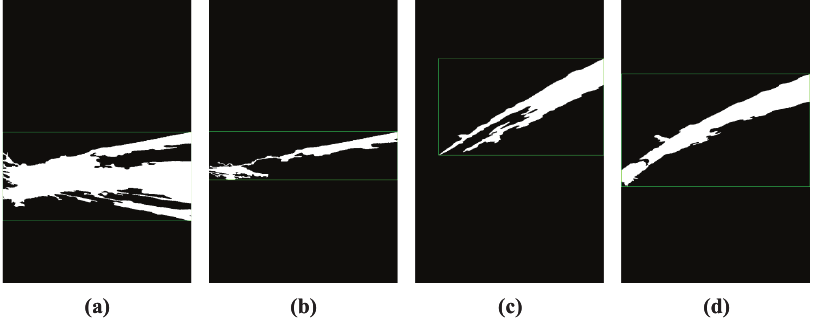
Figure 2. Different jet trajectory segmentation results. ( a ) wrongly trajectory result 1; ( b ) wrongly trajectory result 2; ( c ) wrongly trajectory result 3; ( d ) satisfactory trajectory result.